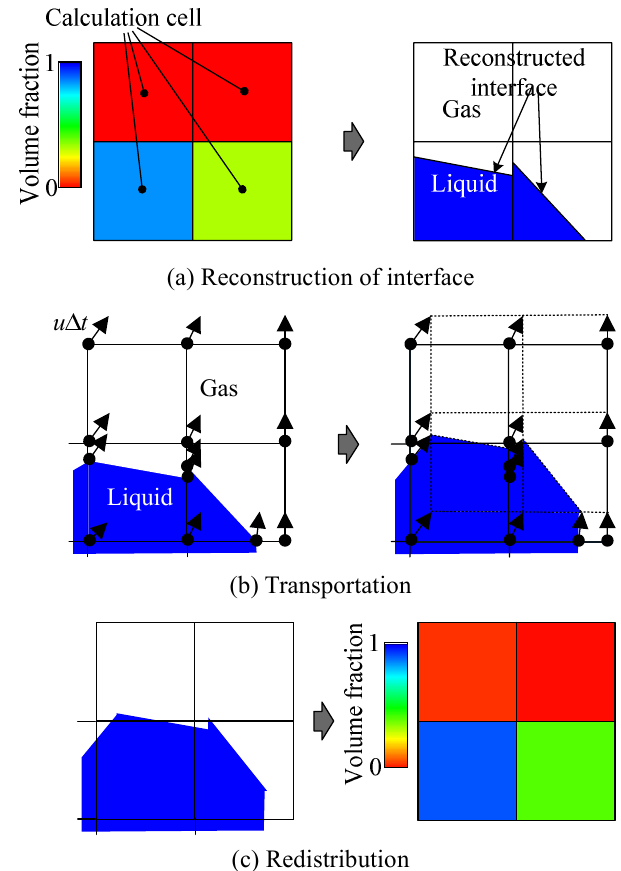
Fig.1 Schematic drawings of volume fraction transport calculation by the advanced interface tracking